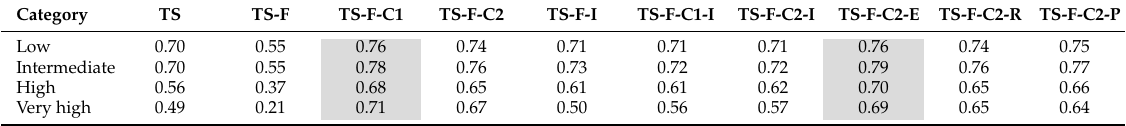
Table 5. Confidence-based quality assessment of land cover classifications for each category based on a specific scenario to handle invalid pixels. TS: time series, F: filtering for low-quality observations, Cx: compositing with (cid:8) x years, I: linear temporal interpolation, E: elevation, R: Radar data, and P: precipitation. Grey cells mark best results for runs with and without ancillary